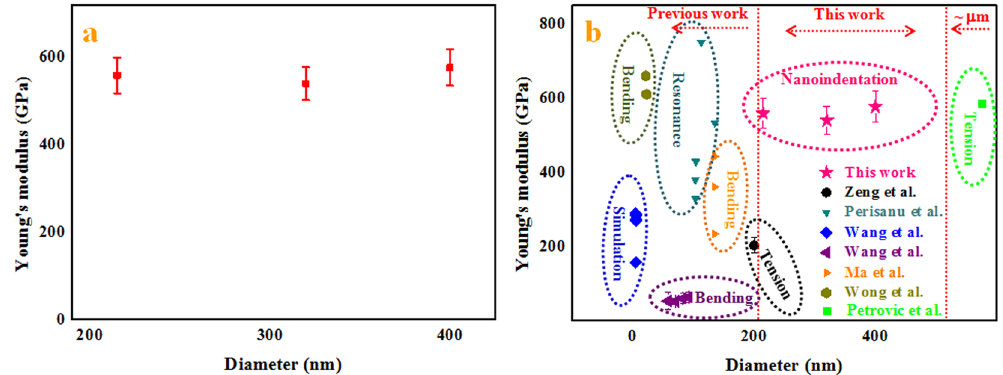
Figure 8. ( a ) The Young’s modulus values as a function of the diameter of the SiC NWs. ( b ) The Young’s modulus of the SiC NWs and whiskers as a function of the